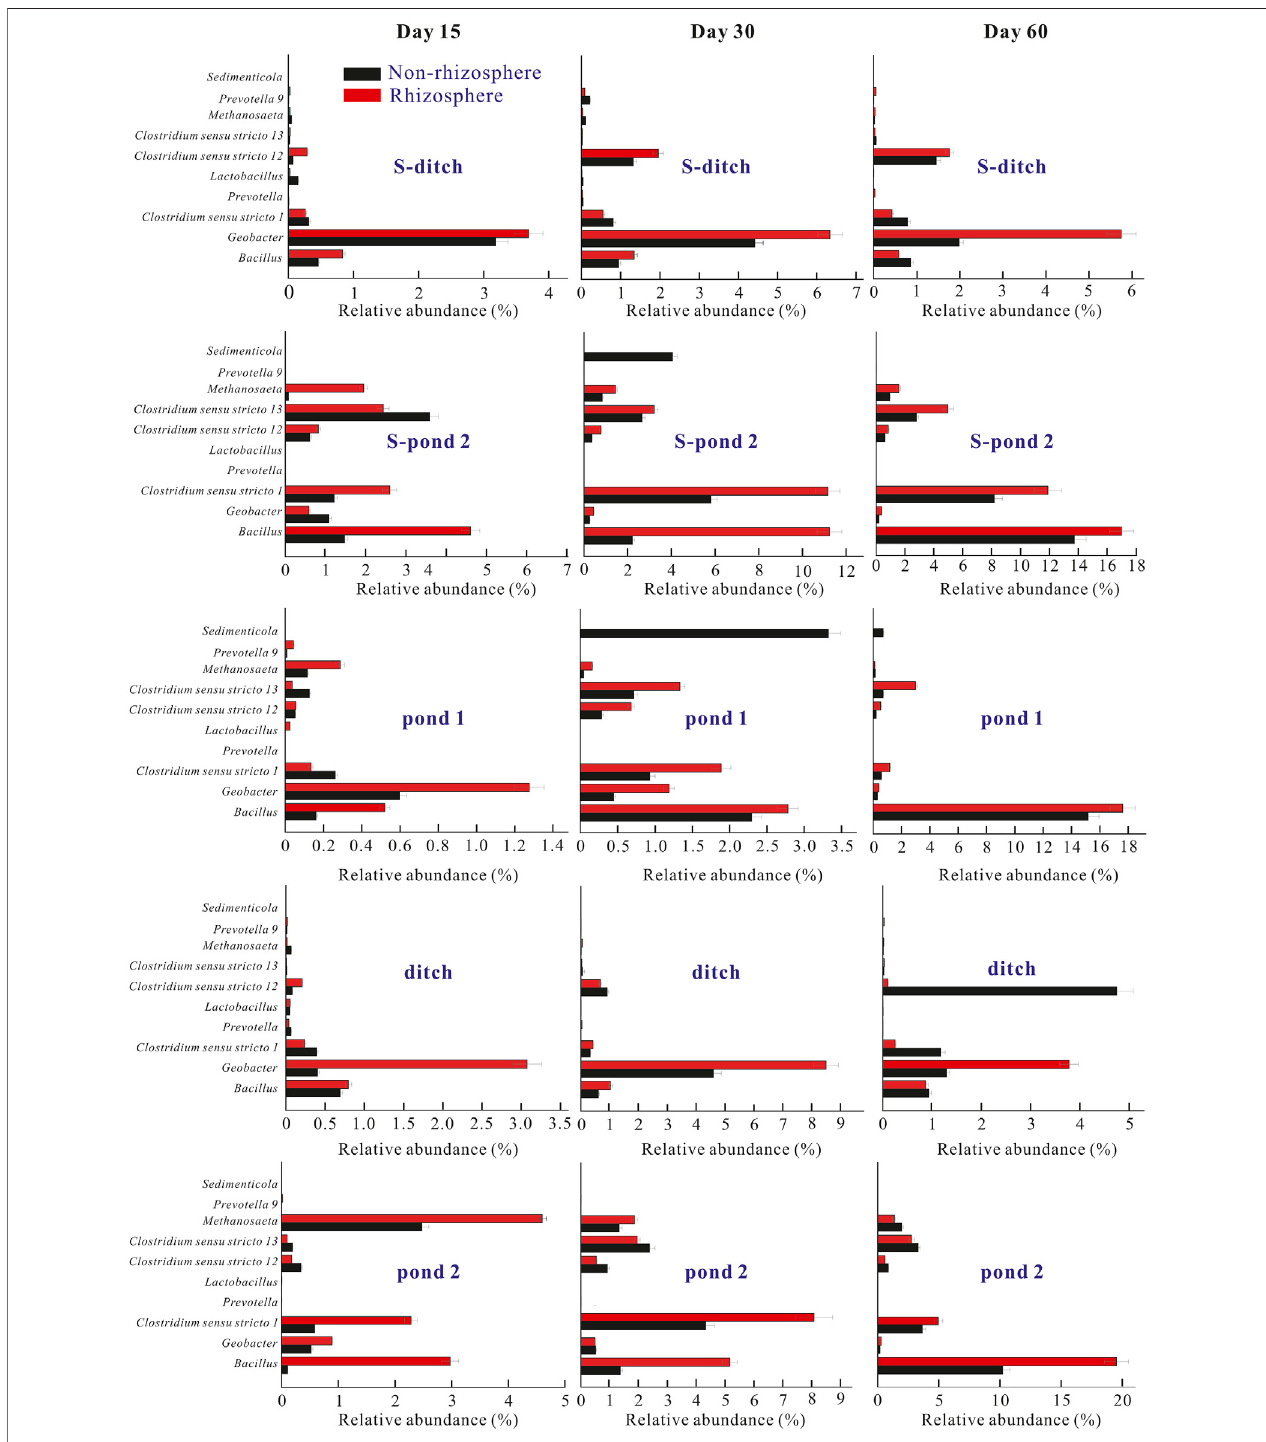
FIGURE5| Relative abundances oftop10bacteriaat thegenuslevel inthe twosystems. Therelativeabundancesoftop 10bacteria at thegenus level at days 15, 30, and 60 were calculated. Abbreviations: In the static systems, S-ditch, S-R-ditch, S-pond-2, and S-R-pond-2 mean the sediments collected from the ditch, plant rhizosphere in the ditch, pond 2, plant rhizosphere in pond 2, respectively. The plants in the pond 1 of the static system died at the early stage of the experiment. In the PDCS,Pond-1, R-pond-1,ditch, R-ditch,pond-2,andR-pond-2representedthesedimentscollectedfromthepond1,plantrhizosphereofthepond1,theditch, plant rhizosphere in the ditch, pond 2, plant rhizosphere in the pond 2, respectively.